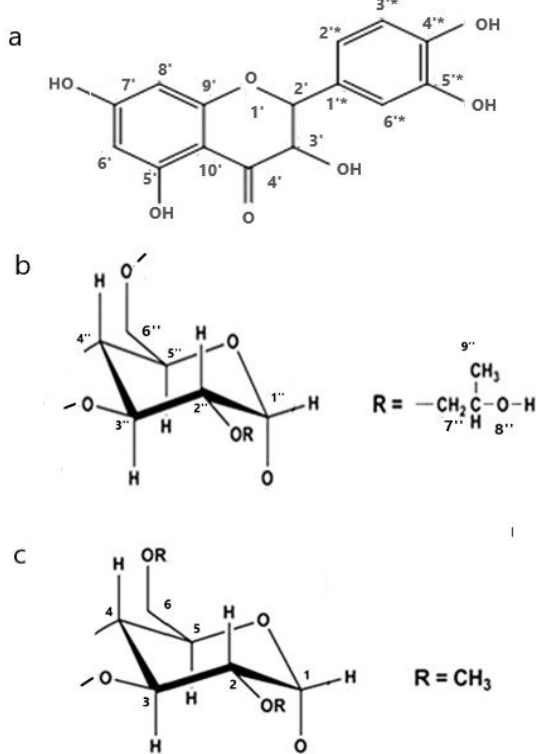
Figure 1. Chemical structure of ( a ) quercetin, ( b ) 2,6Me- β -CD and ( c ) 2HP- β -CD. Cyclodextrins (CDs) are a group of cyclic oligosaccharides consisting of sugar monomers [ α -D-glycopyranose], which are linked by α -[1,4]-glycosidic bonds. The natural CDs α , β and γ consist of 6, 7 and 8 glucose units, respectively. Apart from these naturally occurring CDs, many derivatives have been synthesized such as randomly methylated derivatives of β -CD [RM- β -CD], 2-hydroxypropylated β - and γ -CDs [HP- β -CD, HP- γ - CD], sulfobutylated- β -CDs [SBE- β -CD], branched CDs [glucosyl- and maltosyl- β -CDs], acetylated β - and γ -CDs and sulfated CDs. Their structures consist of a hydrophilic